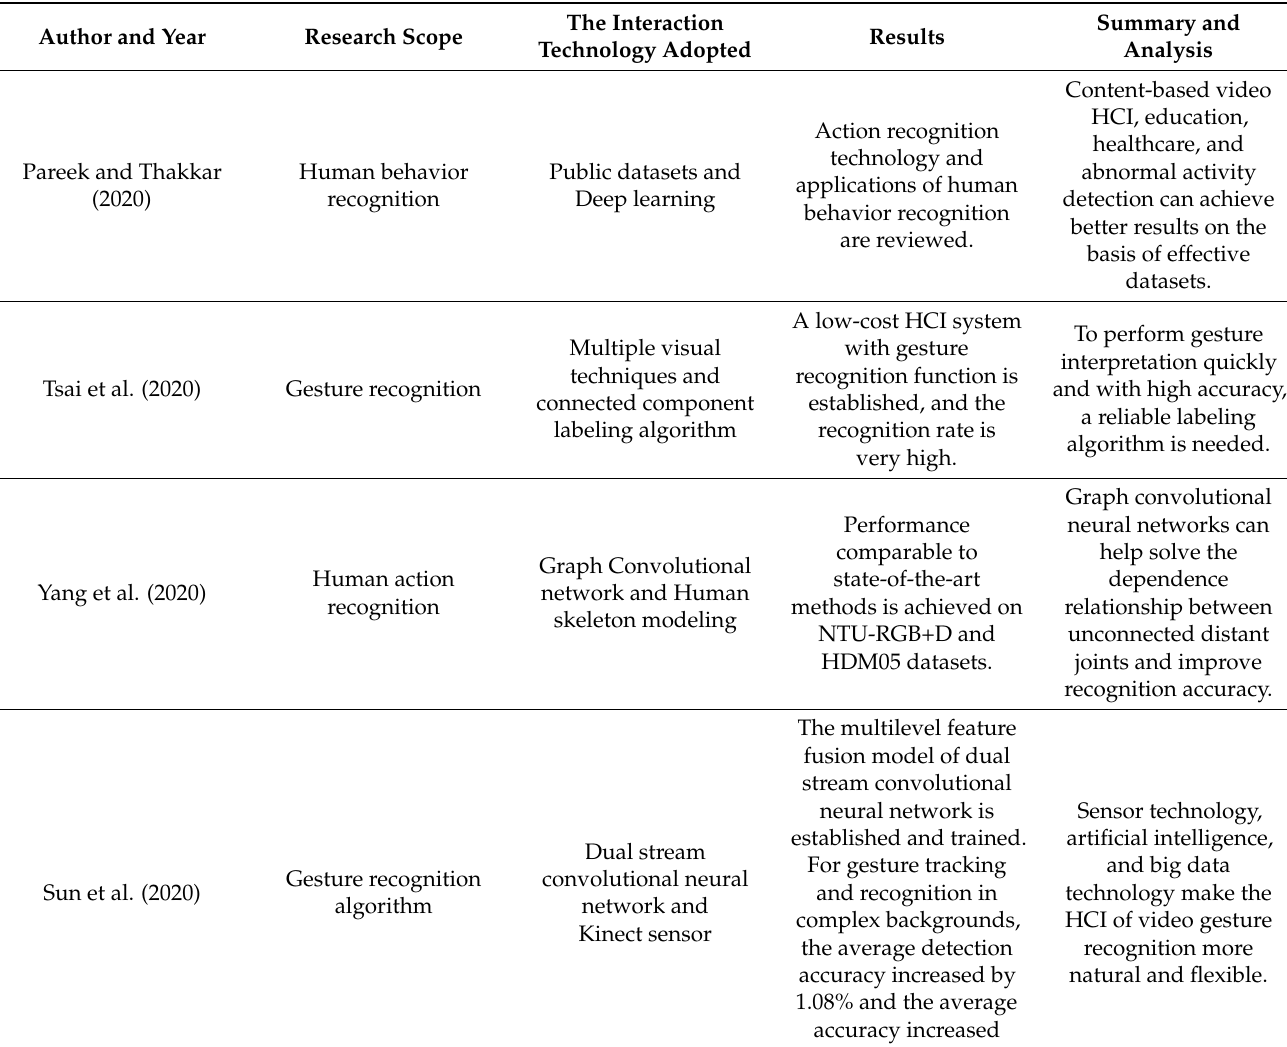
Table 2. Development status of deep learning technology in assisting gesture interaction in intelli- gent